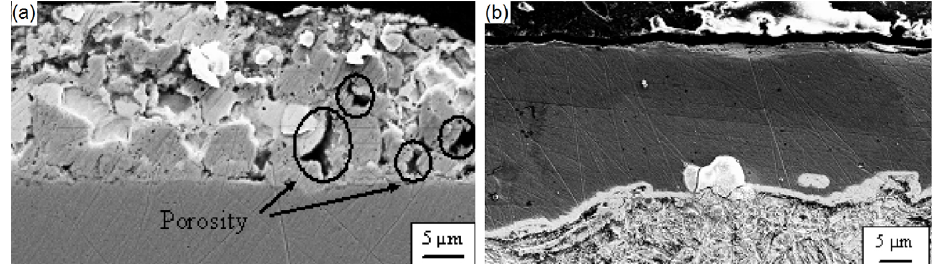
Fig. 10 Scanning electron micrographs of the cross section of (a) highly porous mechanically plated Zn–Sn, and (b) highly dense electroplated Al coatings on steel rivets’ head. Reproduced with permission from Ref. [61], © Trans Tech Publications Ltd, 2012.